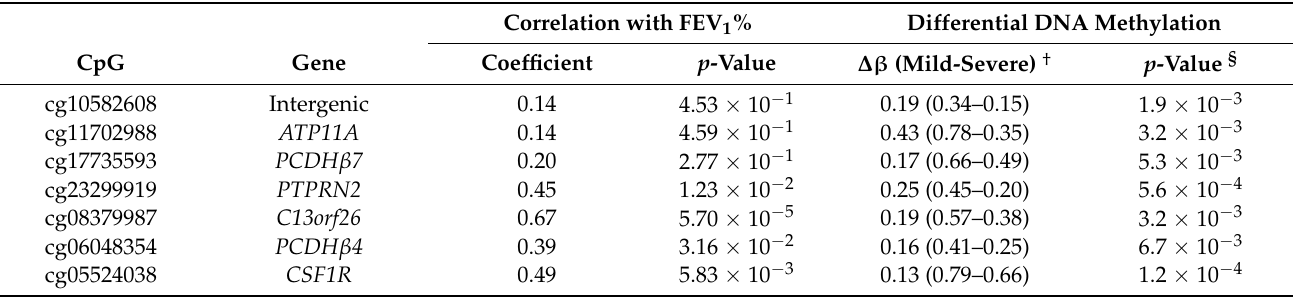
Table 1. Seven biomarkers were selected using a DNA methylation dataset generated in nasal epithelial cell samples from the MethylCF cohort.